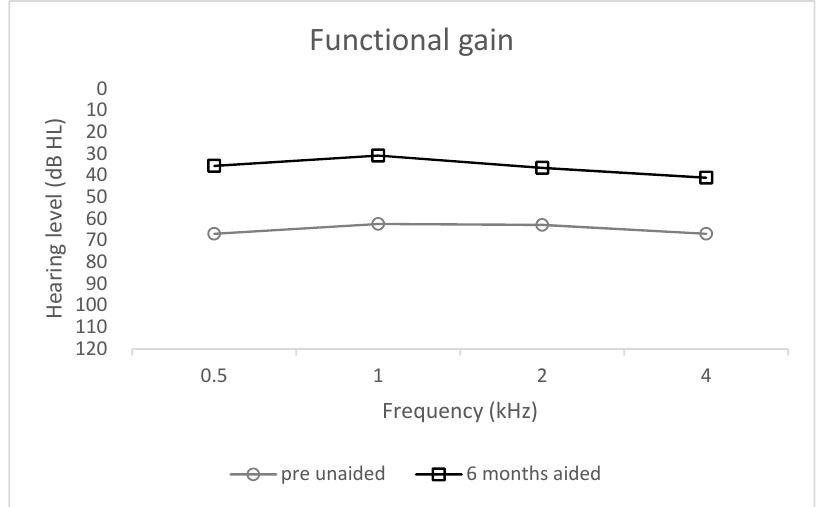
Figure 5. Functional gain; unaided and 6 months aided.